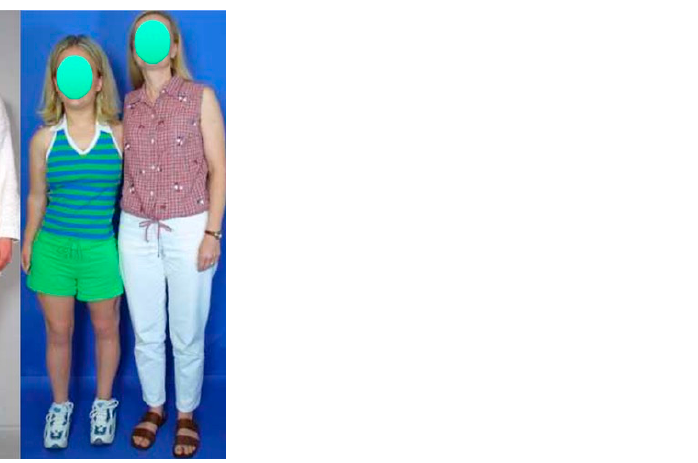
Figure 1. Photographs of a female patient with achondroplasia standing beside her mother at age 13 ( left ) and at age 17 ( right ). Her height increased from 4 ′ (122 cm) before lengthening to 5 ′ 1.5 ″ (156 cm) after two lower-limb 2-segment lower-limb adolescent-onset lengthenings totaling 10.25 ″ (26 cm). She also had 10 cm of lengthening of her humeri.